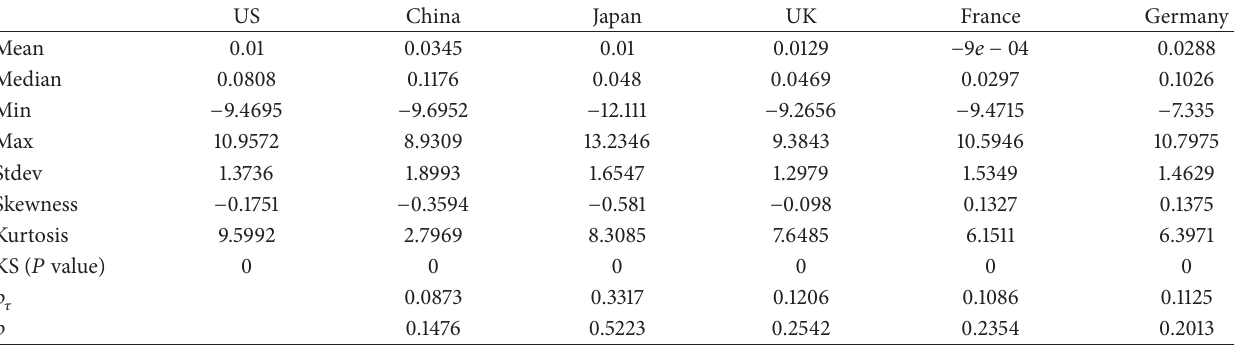
Table 1: Summary statistics of log daily index returns. This table provides summary statistics of log daily index returns for six markets, including the US (S&P 500 index), China (CSI 300 index), Japan (Nikkei 225 index), UK (FTSE-100 index), France (CAC-40 index), and Germany (DAX index) from June 1, 2006, to July 25, 2013. The Kendall tau correlation coefficient ( 𝜌 𝜏 ) and Pearson correlation coefficient ( 𝜌 ) between the US and tested countries are also reported. US China Japan UK France